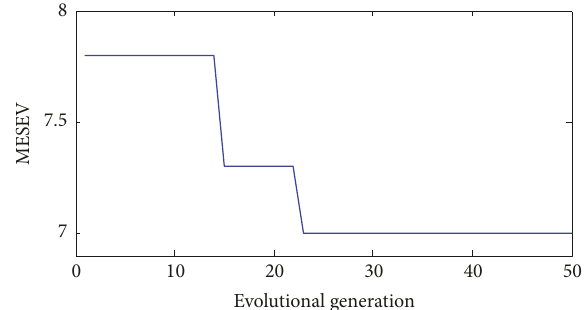
Figure 9: The relation curve between MESEV and Evolutional generation.